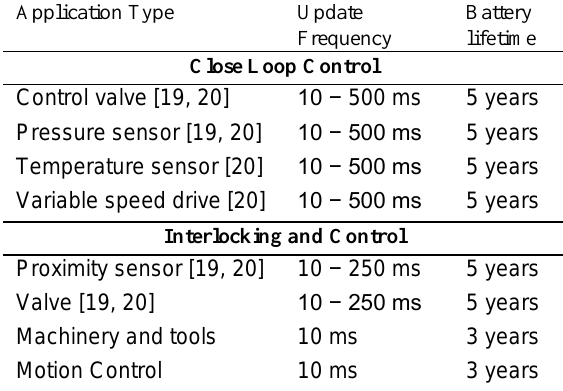
Table 1. Delay and update requirements for industrial processes [16-18]